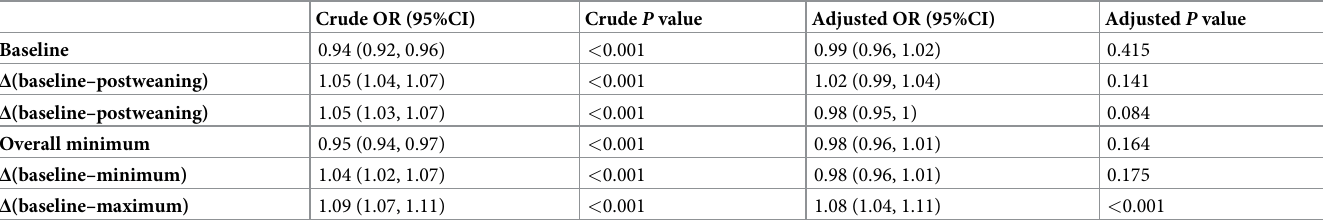
Table 3. Logistic regression analysis.